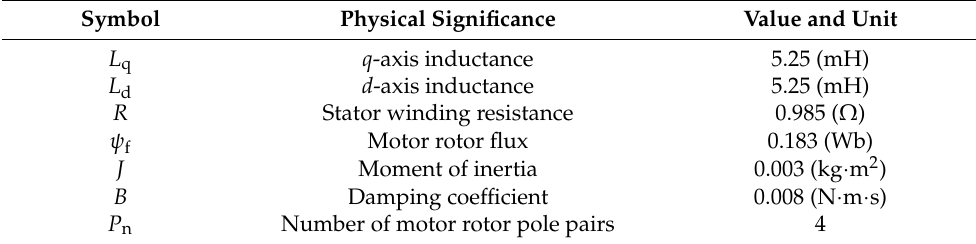
Table 1. Basic parameters of a permanent magnet synchronous motor [28].